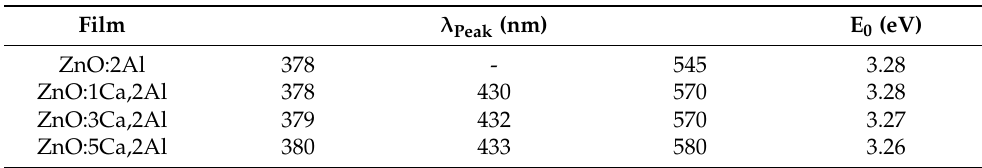
Table 2. PL Emission peaks and the excitonic energy (E 0 ) of ZnO:Al 2% and Ca-doped ZnO:Al 2% thin films with: 1, 3 and 5% Ca.